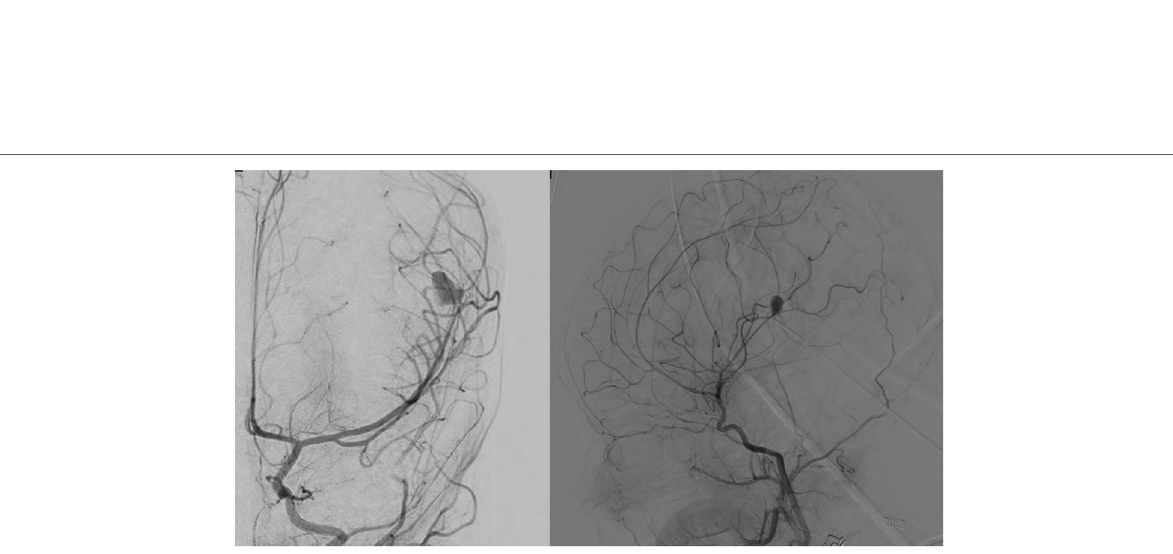
3 cm in size. No thrombosis. No contrast ×